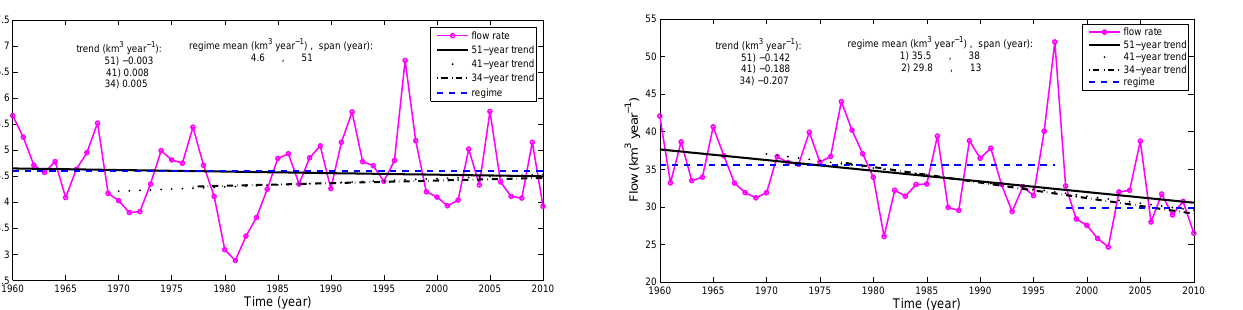
Fig.6. DetectedtrendsforthreedifferentanalysisperiodsinFondduLacRiver.Thesetrendsarenotsignificant( p -value ≥ 0.10).